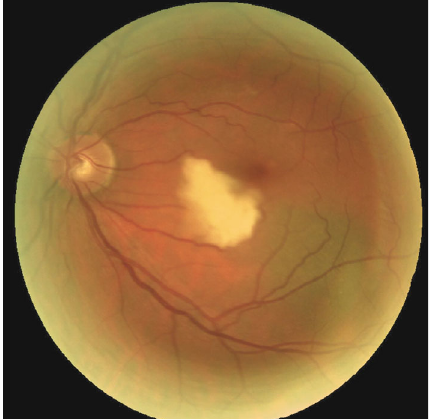
Figure 2: Fundus photograph of the left eye branch retinal artery occlusion (BRAO) showing white pallor at the inferior temporal branch of the central retinal